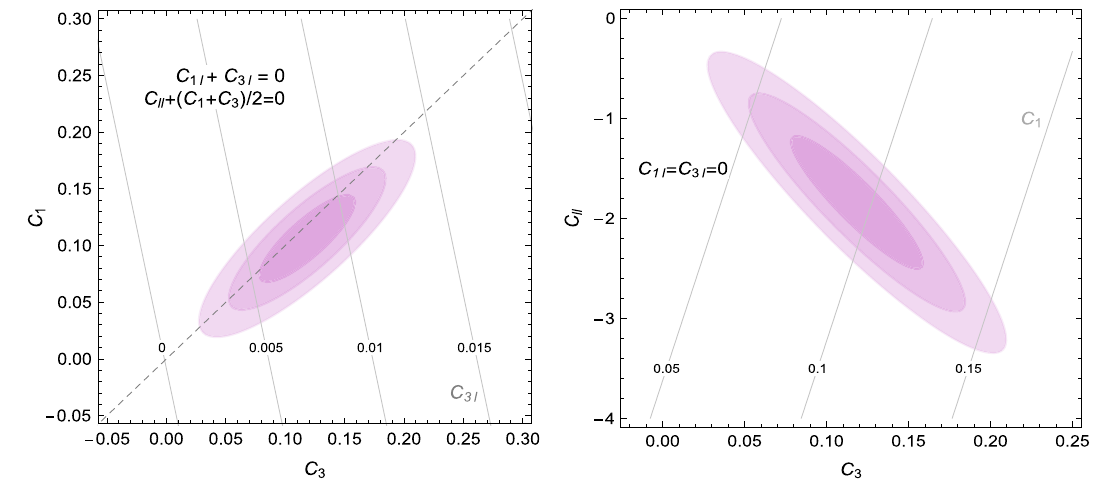
Fig. 1 Fitof R ( ∗ ) ,Eq.(30),andofthecorrectionsto W / Z couplingsofEq.(41).Leftpanel:fitto C 3 , C 1 and C 3 l = − C 1 l with C ll = − ( C 1 + C 3 )/ 2. D The full isolines are for C 3 l . The dotted line is for C 1 = C 3 . Right panel: fit to C 3 , C 1 and C 3 l = C 1 l = 0. The isolines are for C